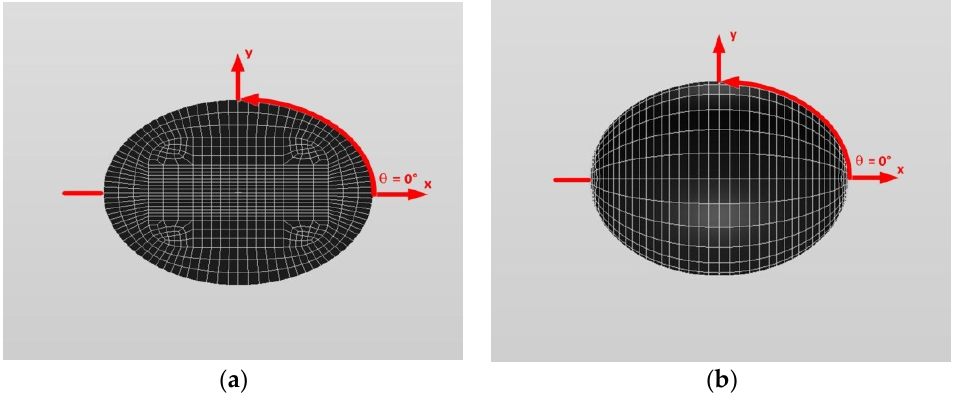
Figure 16. A typical discretized oblate spheroidal model (b/a = c/a = 0.5) in the volume integral equa- tion method (VIEM). ( a ) An inside view of an oblate spheroidal model. ( b ) An oblate spheroidal model.